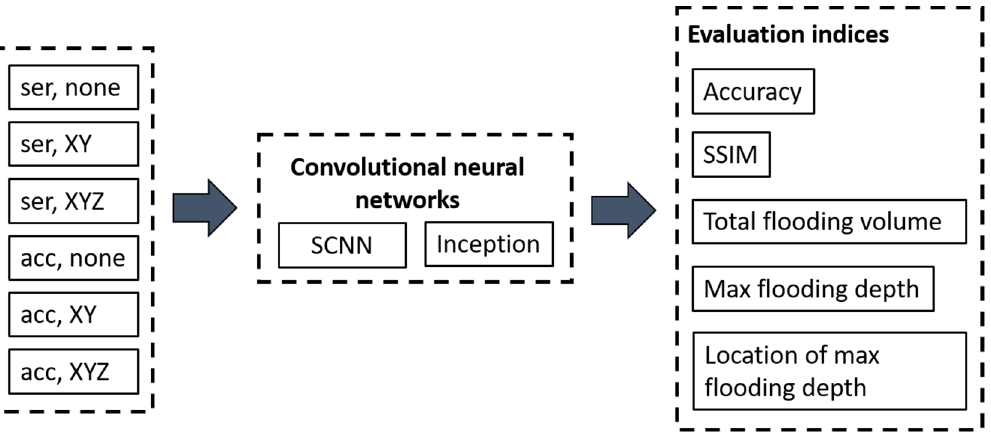
Figure 8. Data of different combinations are input to two CNN architectures (SCNN and Inception). The obtained results are compared in various ways. Table 3. Twelve models.